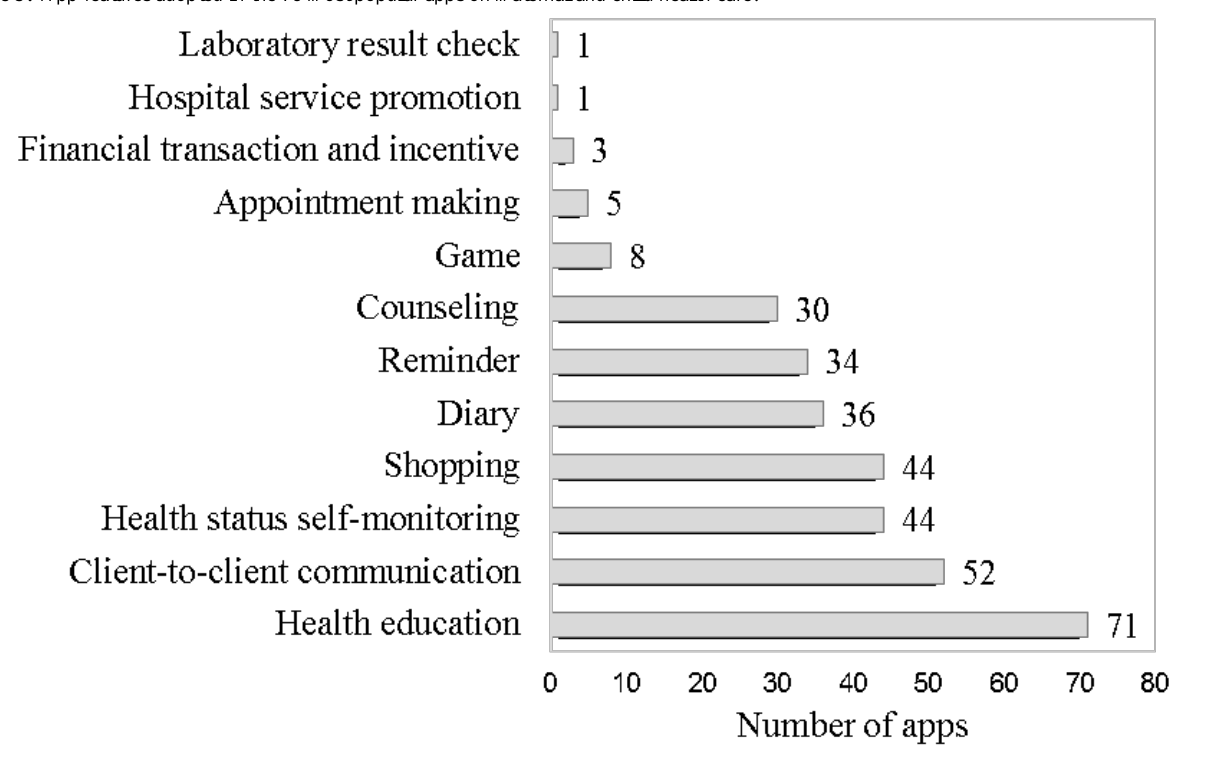
Figure 3. App features adopted in the 78 most popular apps on maternal and child health care.